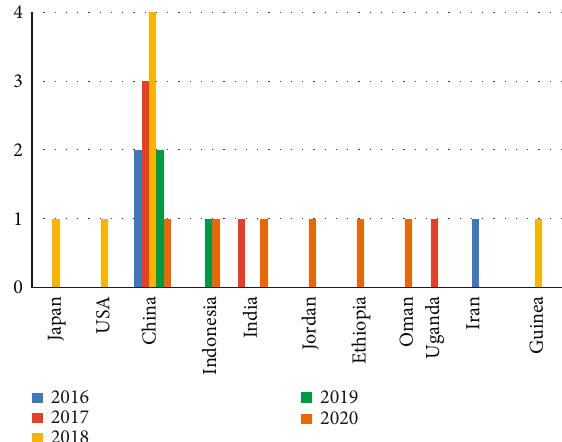
Figure 9: Country of urban development/year.